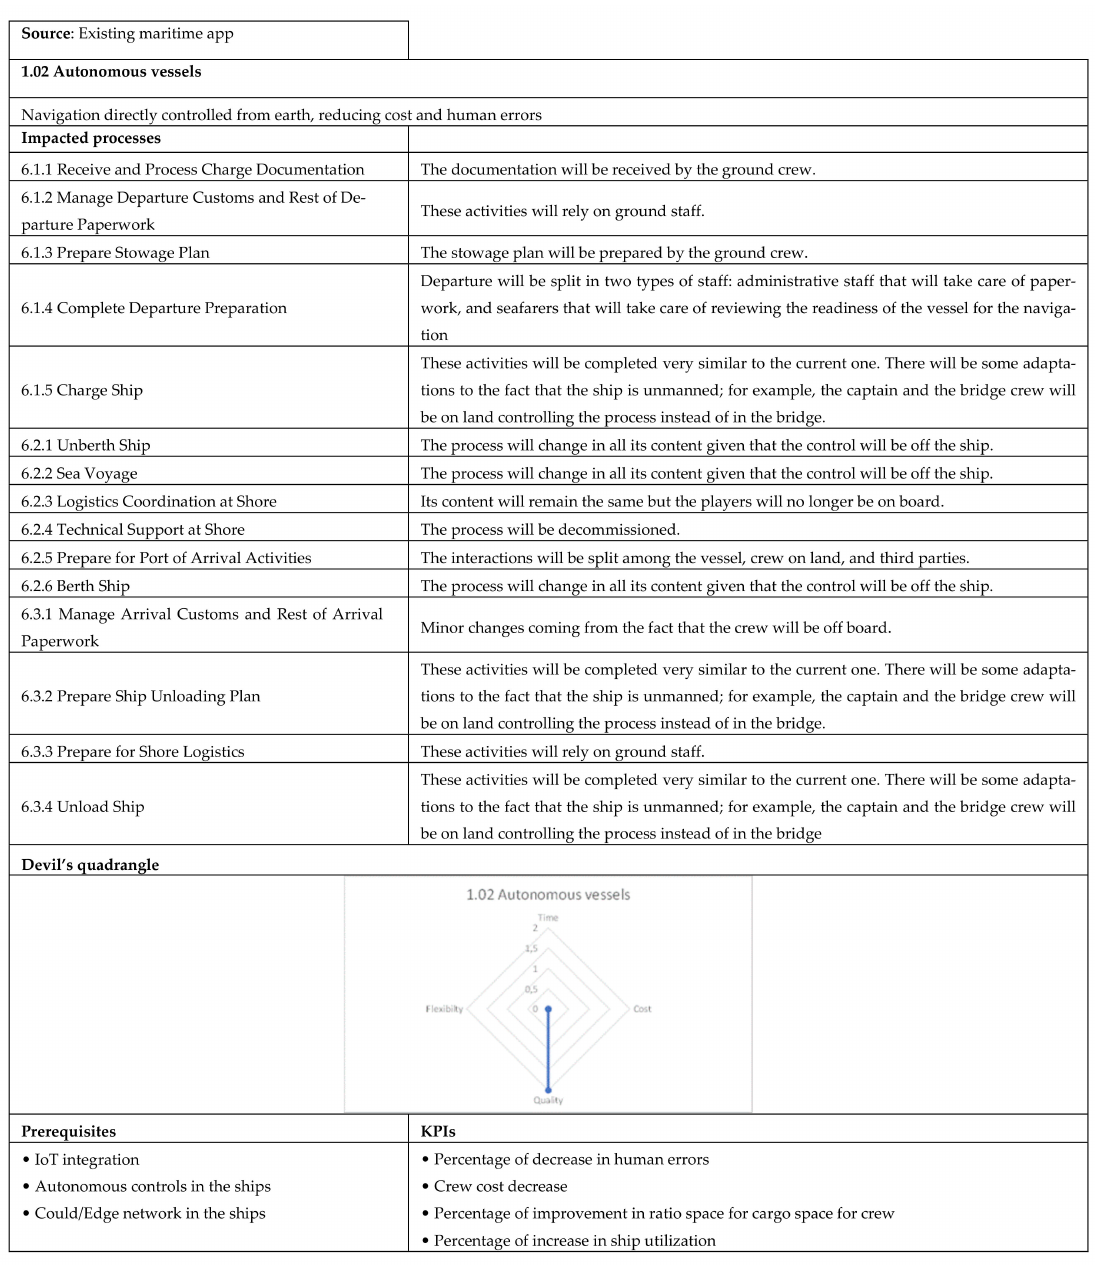
Figure A2. Autonomous vessels data sheet.